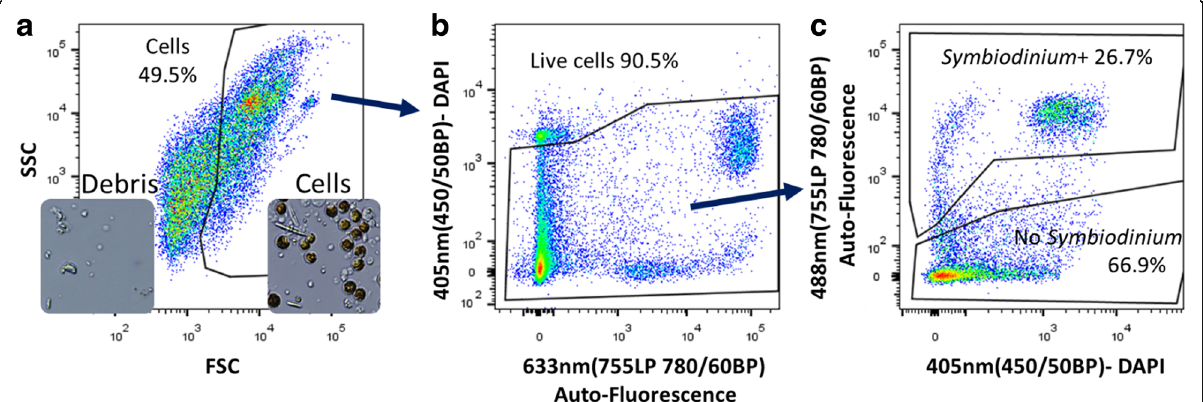
Fig. 1 Coral cell gating strategy for population analysis by FACS. a ) P. damicornis cell suspension analyzed using FACS ARIA II according to their intrinsic size (FSC) and granularity (SSC) properties on a log scale, exited by 488 nm laser. The gate separates cells from debris. Within the inserts are representative images of the sorted cells or debris populations. Blue scale bar = 20 μ m. b ) Gating on live cells out of the cell gate using 405 nm (450/50BP)- DAPI negative gate. The fluorescent gates are in two dimensions due to P. damicornis and Symbiodinium natural auto- fluorescence. c ) After excluding debris and dead cells the 488 nm (755LP 780/60BP) channel was used to measure Symbiodinium auto-fluorescent in this Far-Red channel to differentiate cells with or without